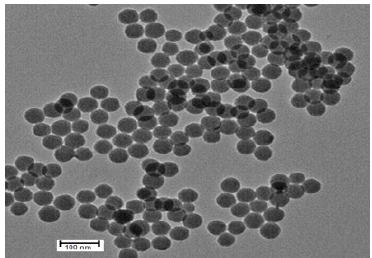
Figure 8. TEM scans from particles synthesized with 0.8 TEOS molar ratio.